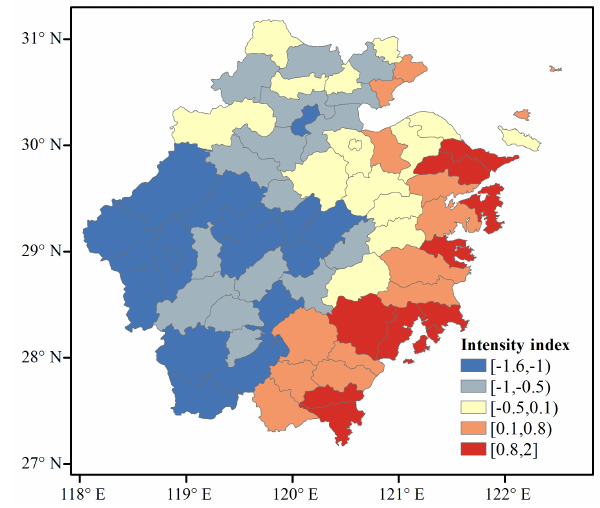
Figure 8. Intensity indexes of factors causing typhoon disasters at each station in Zhejiang